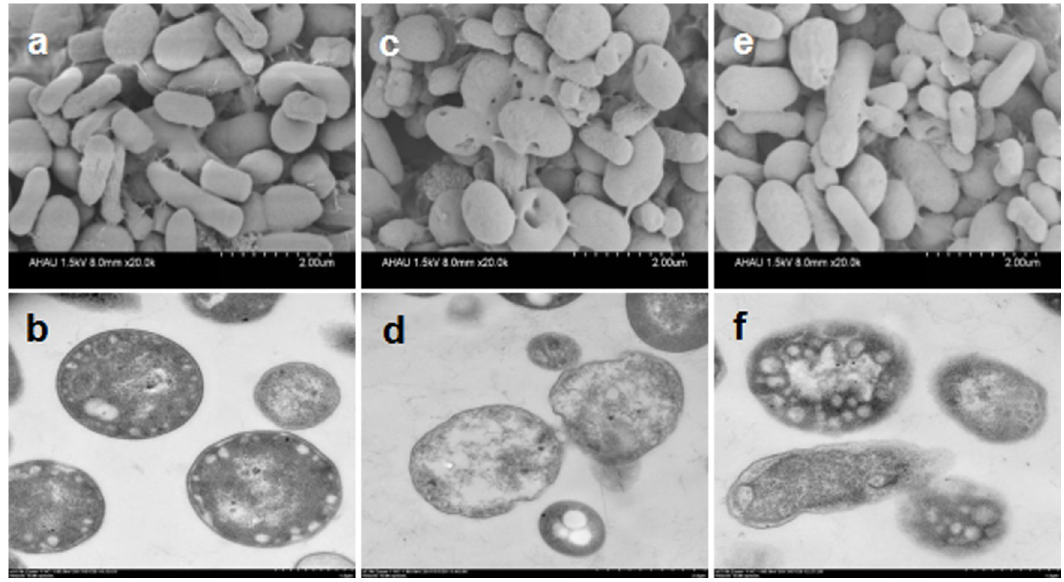
Fig 3. The effect of AgNPs on the cell morphology of A . vinelandii observed by SEM (upper) and TEM (lower). (a) SEM and (b) TEM images of a control group in which no AgNPs are added; (c) SEM and (d) TEM images of nano-Ag 10 at a concentration of 10 mg/L; (e) SEM and (f) TEM images of nano-Ag 50 at a concentration of 100 mg/L. All treatment groups were exposed for 12 h.